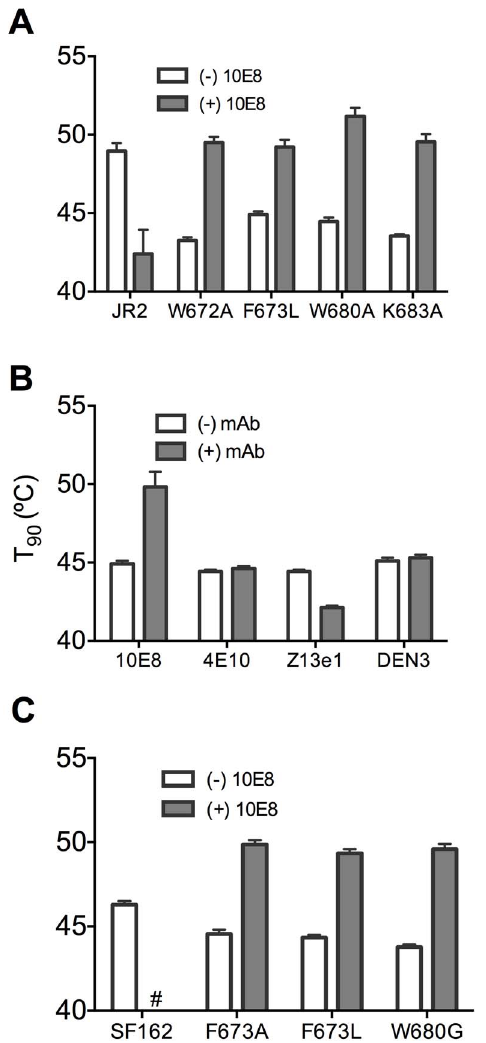
Figure 9. Presence of 10E8 enhances functional thermostability of multiple MPER mutants of JR2 and SF162 within the 10E8 linear epitope. ( A ) The presence of 10E8 at a concentration in the maximum neutralization plateau (10 m g/ml) enhances functional thermostability (T 90 ) of multiple MPER mutants of JR2. Hash tag ( # ) indicates insufficient infectivity. ( B ) The effect on the functional thermostability of JR2 F673L by the presence of control antibodies 4E10, Z13e1 and DEN3, which are non-neutralizing, neutralizing and irrelevant antibodies against this mutant, respectively. 4E10 and Z13e1 were used at 50 m g/ml and DEN3 was used at 100 m g/ml. ( C ) Functional thermostability of SF162 in the presence of 10E8 at a concentration in the maximum neutralization plateau (10 m